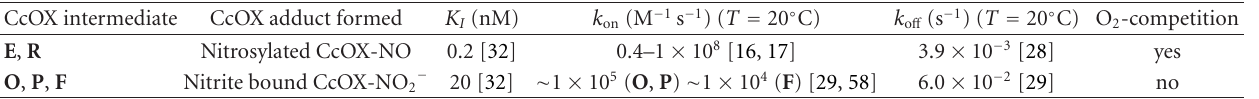
Table 1: Cytochrome c oxidase versus NO—kinetic and thermodynamic